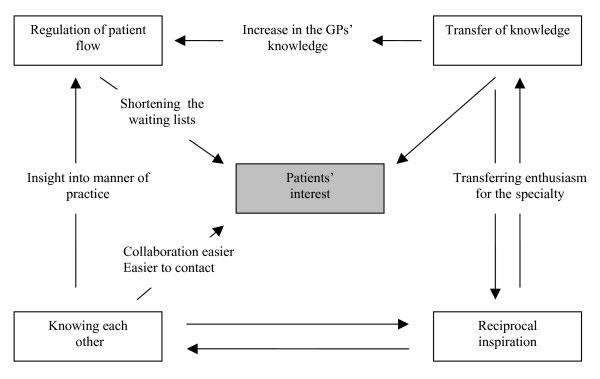
The most important motives for specialists to work collaboratively.